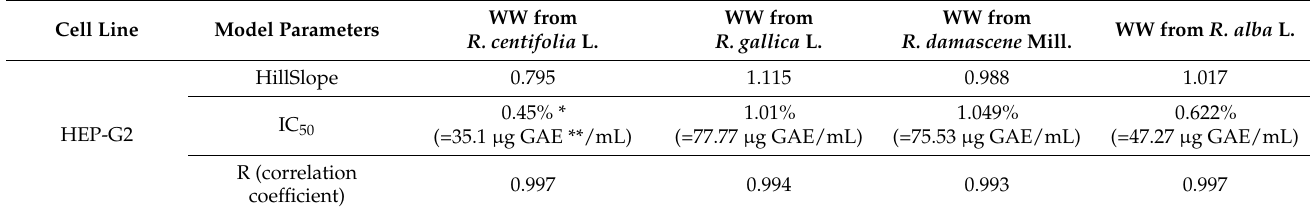
Table 3. Median inhibitory concentrations of wastewaters obtained from different rose species in non-tumorigenic and tumor cell lines after 72 h of